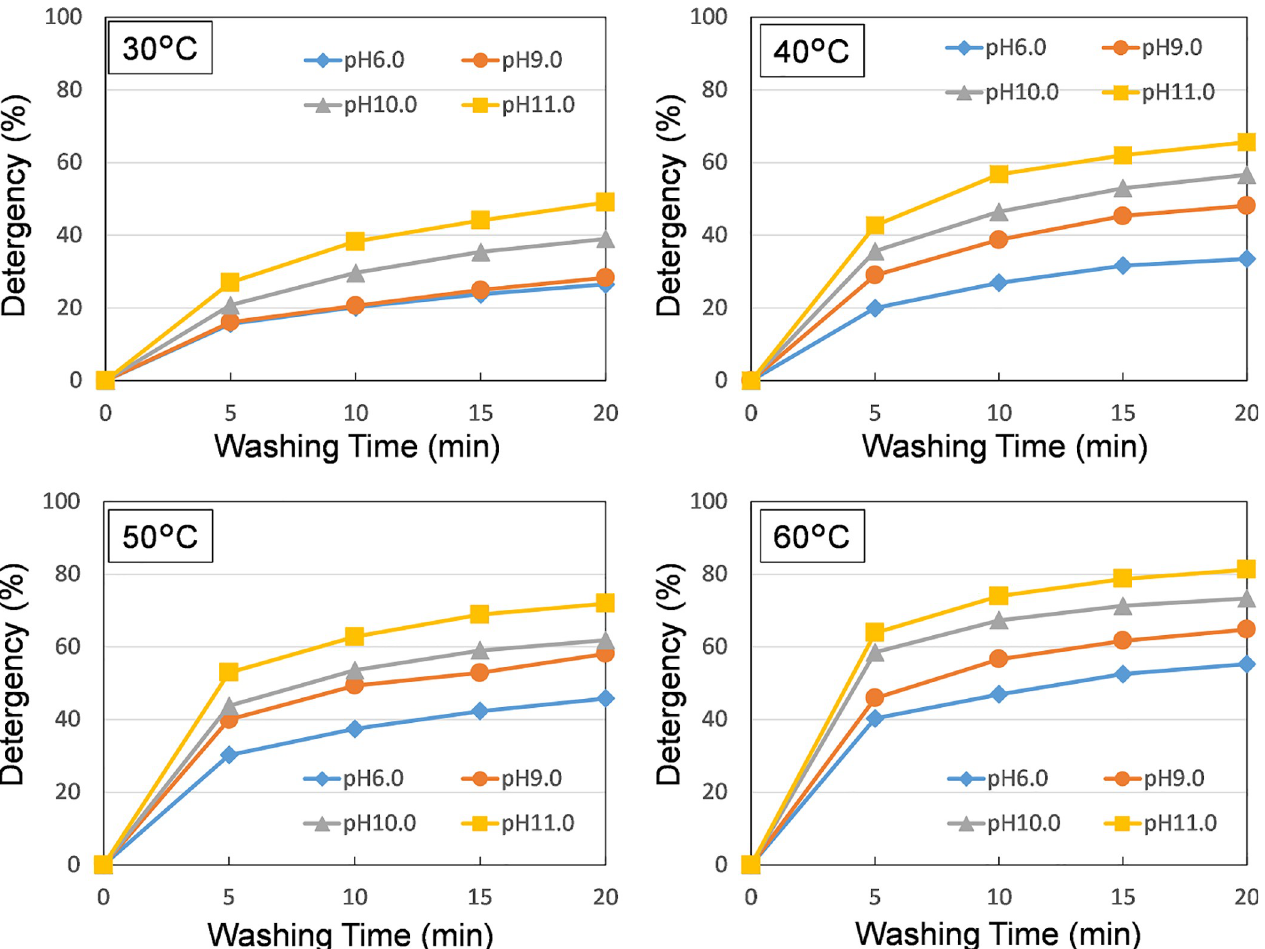
Fig 2. Time dependent detergency curves of hemoglobin soil obtained with respect to various temperature and pH levels (soiled fabrics were washed, and the pH was controlled using NaOH).